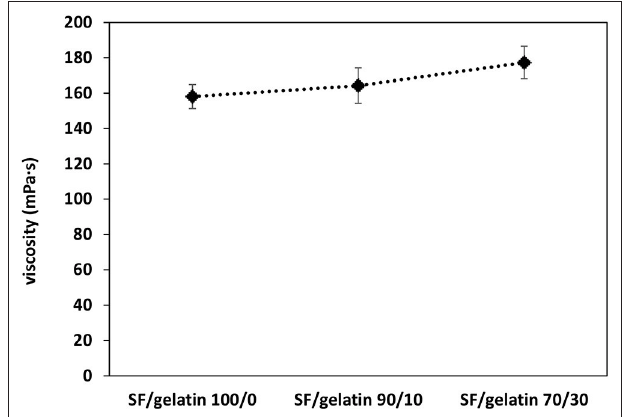
FIGURE 1 | Viscosity measurement of SF/gelatin solution at a constant shear rate of 100 s − 1 .